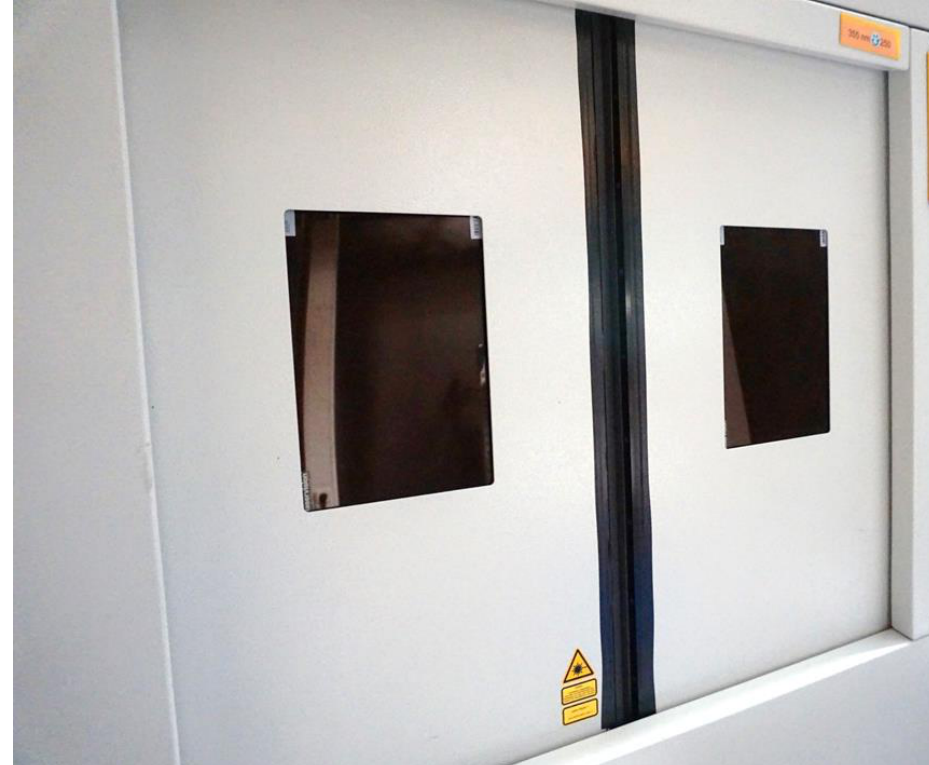
Figure 9. Photograph of the protection housing doors of the second experimental setup. The laser used in the system is a Coherent HR50 USP-laser with an average power of 35 W. The housing is made of 2 mm thick steel, and the windows are made of PMMA covered with a thin sheet of aluminum. Between the two doors there is a narrow area where, in the closed position, only rubber material lips join without any additional steel or aluminum layers.